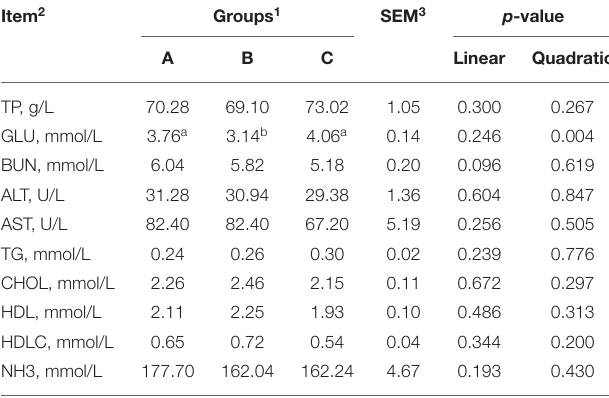
TABLE 3 | Effects of PSR silage on serum biochemical parameters of Angus beef cattle ( N = 5). Item